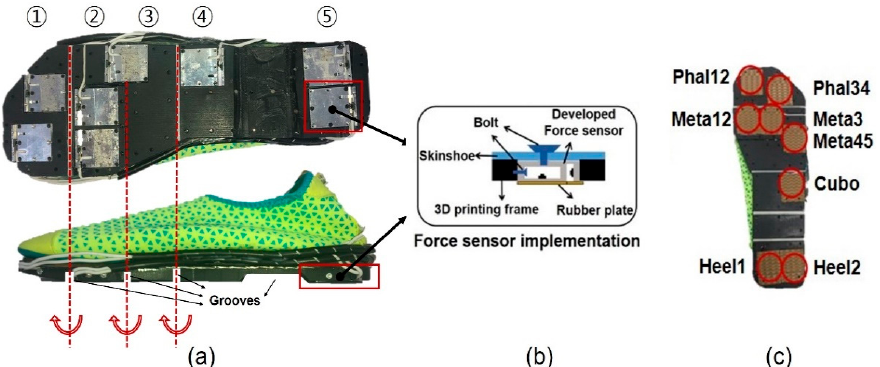
Figure 3. Design of the developed GRF measurement system. ( a ) Installation of the 3D printed